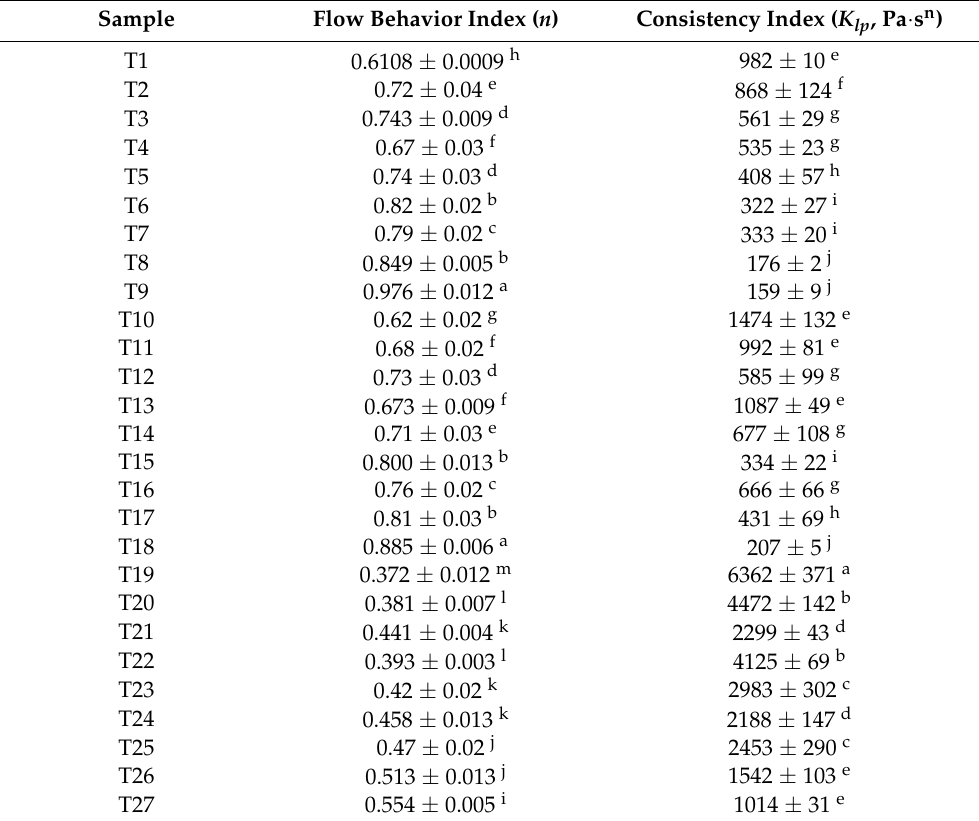
Table 7. Mean values and standard deviation of flow behavior index ( n ) and consistency index ( K lp ) for the studied treatments.